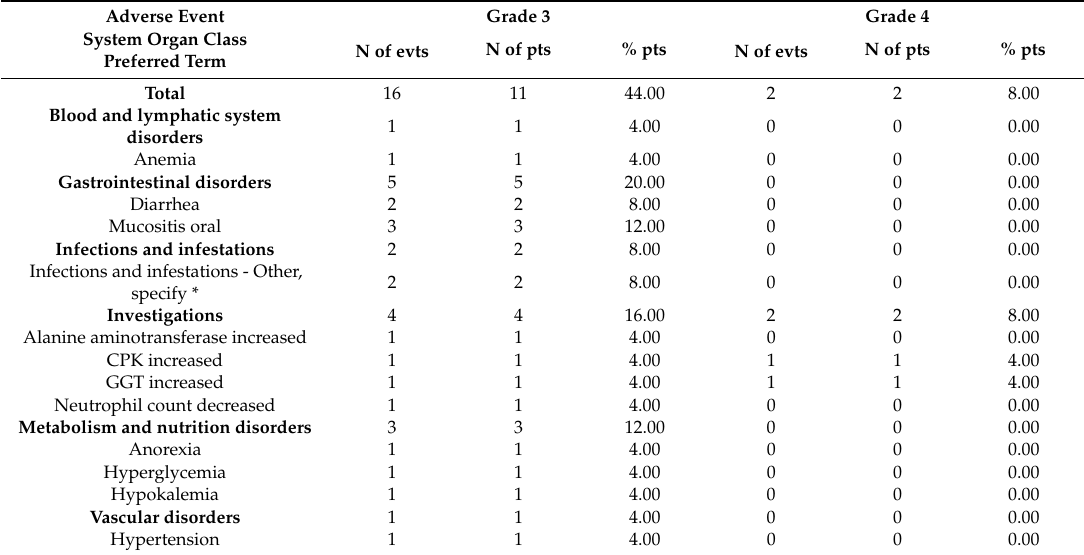
Table 4. The incidence of grade 3 and grade 4 adverse events related to treatment with everolimus. Adverse